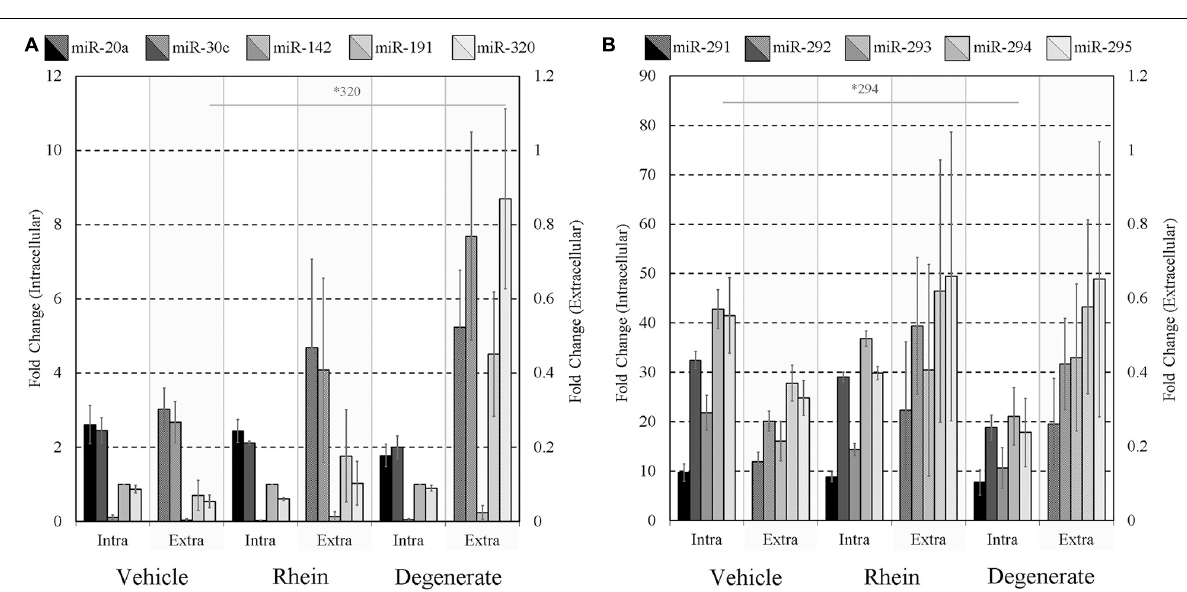
conditioned replicate that produced significantly ( > 10-fold) greater miRNA levels. The fractions of the sequences contained within the spent culture media are approximated in Table 3